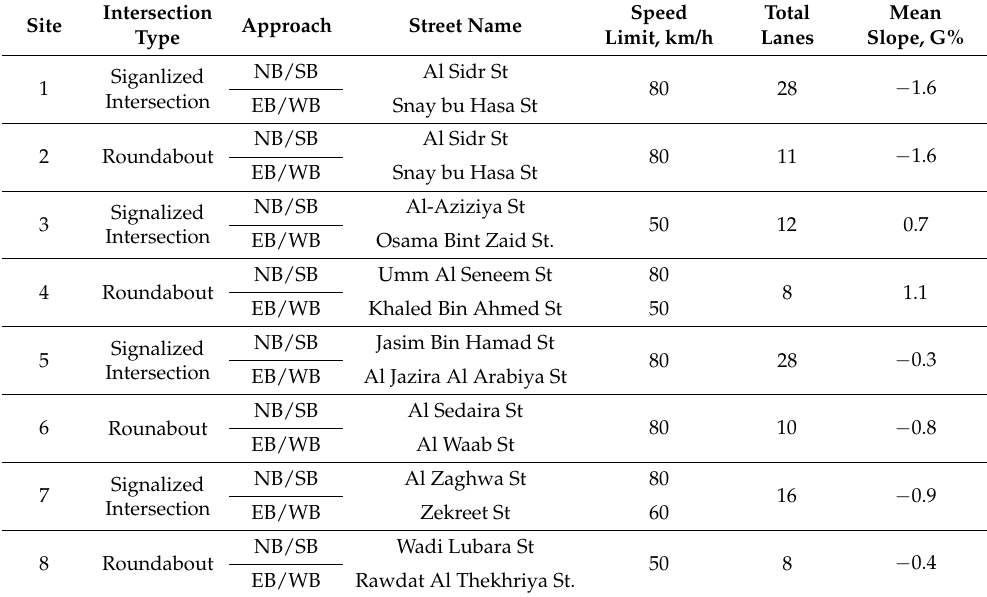
Table 3. Characteristics of the study intersections.